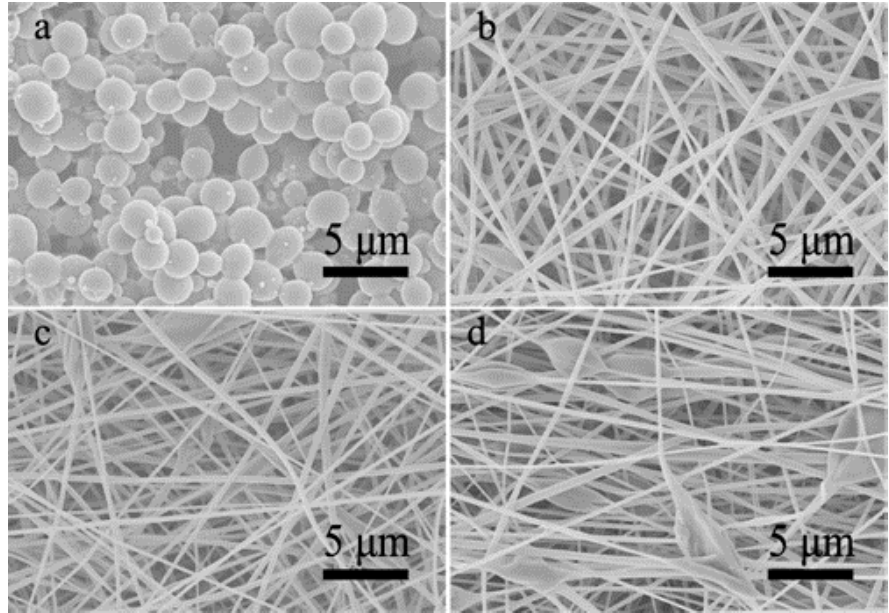
Figure 6. ( a ) An SEM image of single-nozzle electrospray of PLGA-D solution; ( b – d ) SEM images of co-electrospinning of core PLGA-D solution and shell CA-AD21 solution under core-to-shell flow ratio of ( b ) 1:3, ( c ) 1:1.5 and ( d ) 1:1, respectively.